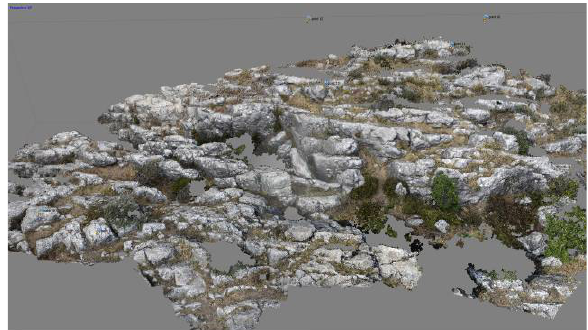
Figure 7. Point Cloud of the rocks produced by PhotoScan